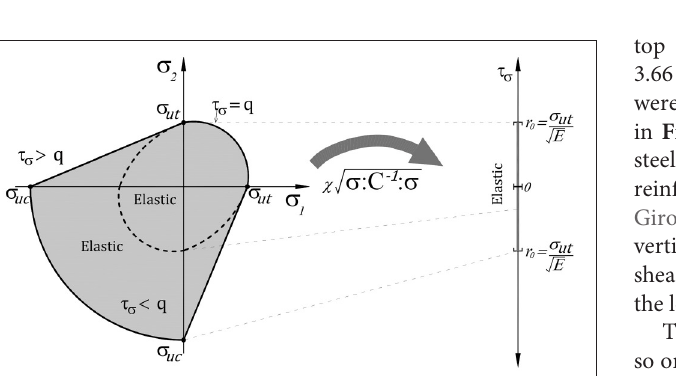
FIGURE 2 | Transformation of the stresses to a norm. (adapted from Juárez-Luna et al.,